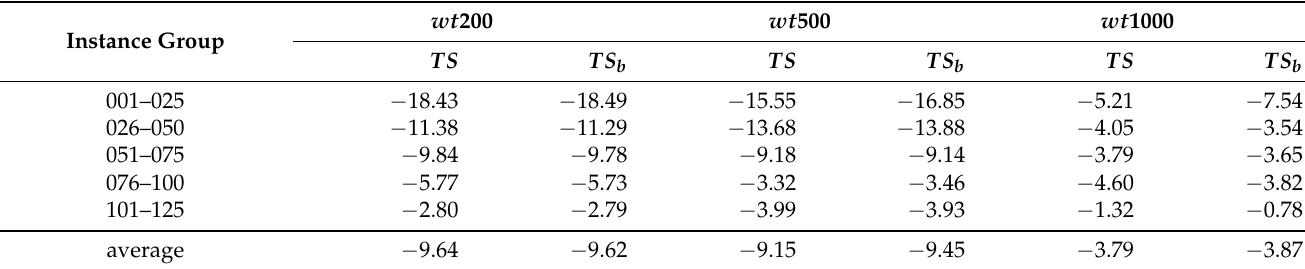
Table 2. Computational results for sequential tabu search algorithm ( t = 120 s, META as reference).